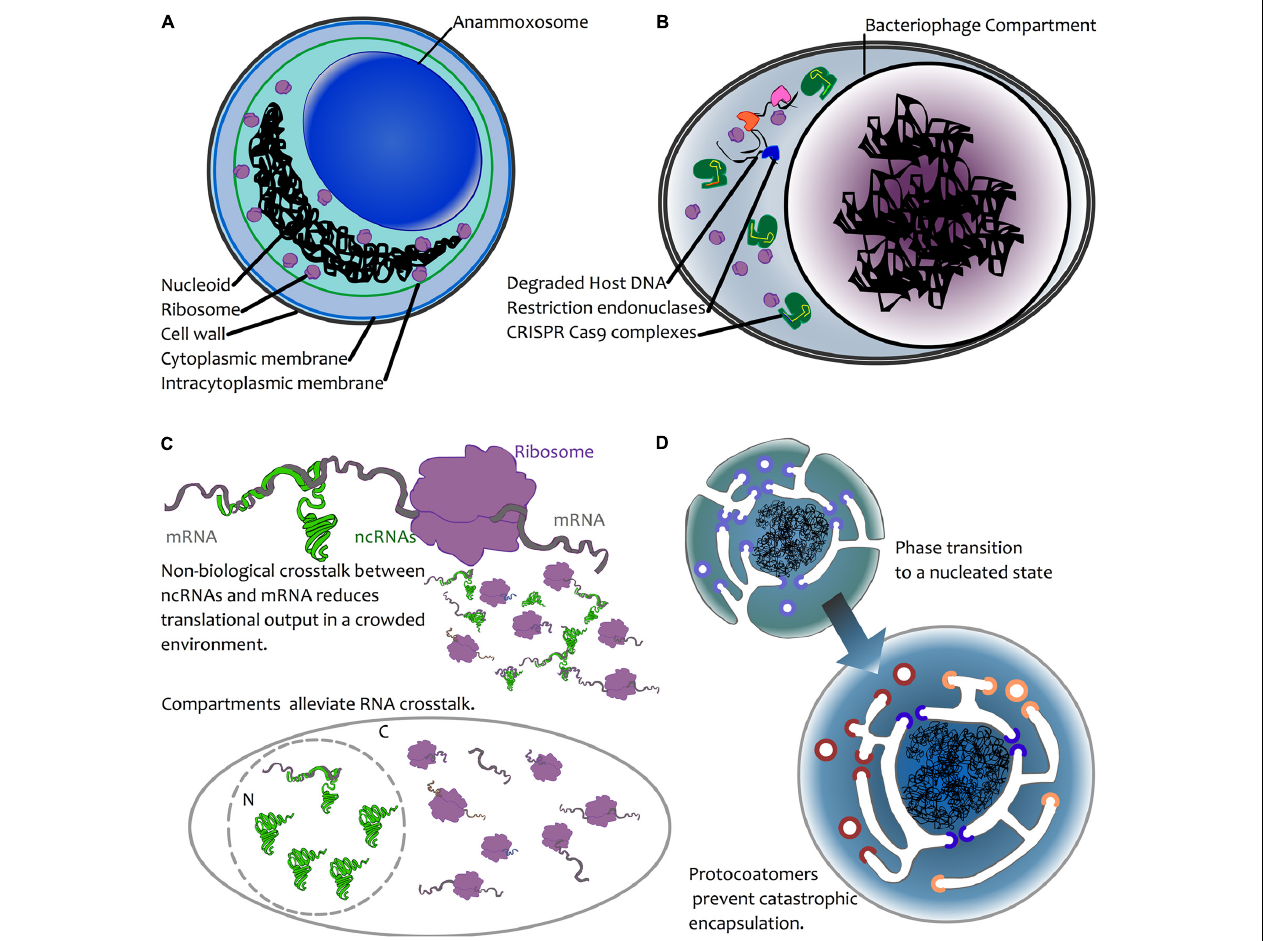
FIGURE 2 | Possible mechanisms for compartmentalization of genetic material. (A) Chemical sequestration—as seen in annamox bacteria—where anaerobic ammonium oxidation is sequestered away from the rest of the cell in a dedicated compartment, the anammoxosome (van Niftrik, 2013). (B) Biological sequestration—the creation of dedicated viral compartments by large viruses (NCLDVs, Jumbophage) may prevent the action of host defenses or competition by other infectious agents by excluding these during biogenesis. For simplicity, an infected bacterial cell is depicted here, with CRISPR-Cas (green) and restriction endonuclease-based defense mechanisms excluded from the compartment. Restriction endonucleases are depicted in blue, pink orange. (C) Biological avoidance. Top: mRNA (grey) may interact with a ribosome (purple), leading to translation. In the case of ncRNA-mRNA interactions, these may occur through chance base-pairing, leading to reduced translational output. This is depicted by the smaller molecules, where some mRNAs interact with ribosomes, and some are trapped in unproductive interactions with ncRNAs (see text for details). In both prokaryotes and eukaryotes, avoidance of such crosstalk is a result of selection against interactions (Marco, 2015; Umu et al., 2016). Bottom: compartmentation is hypothesized to alleviate crosstalk interactions due to physical separation. The presence of ribosomes in the cytoplasm (C) and ncRNAs in the nucleus (N) reduces the opportunity for ncRNA-mRNA crosstalk to impact translation. (D) Biophysical nucleation. Top left: a protoeukaryotic cell possessing endomembranes and protocoatomers (violet) that enable membrane bending (Devos et al., 2004). Bottom right: following a biophysical phase transition (Braun, 2008), the DNA becomes spontaneously encapsulated. The presence of protocoatomers prevents “catastrophic” encapsulation by forming protopores following membrane fusion. Protopores later diversify into nucleoporins (blue) and protocoatomers into coatomers (red, orange) (Devos et al.,